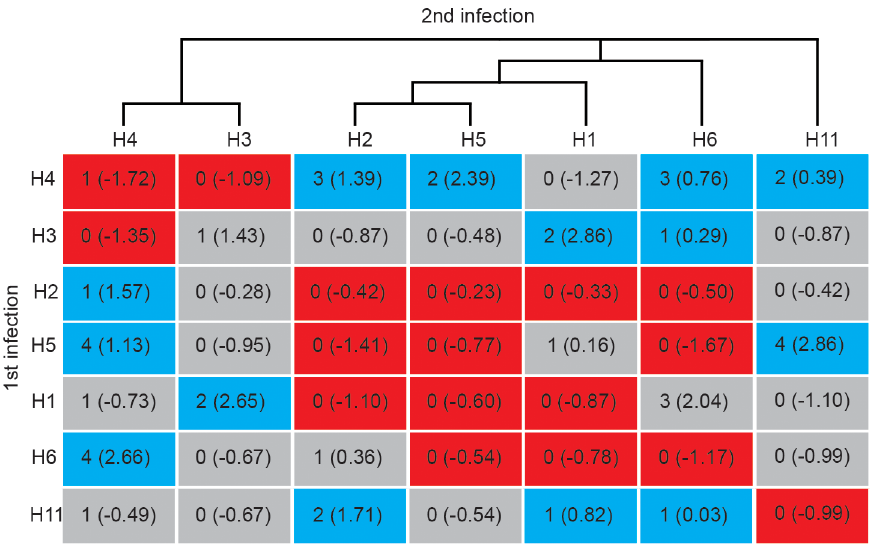
Figure 3. Contingency table for HA re-infections with the IAV subtypes most frequently isolated. Rows represent the HA subtype in the first detected infection and columns the HA from an infection retrieved $ 7 days later. The number in each box represents the number of cases, together with standardized Pearson’s residuals in brackets. Red boxes show negative values and represent a deficiency of cases, blue boxes show positive values and an overrepresentation of cases, and grey denote cases that do not depart from expected values. The dendrogram on top illustrates HA subtype phylogenetic relatedness.